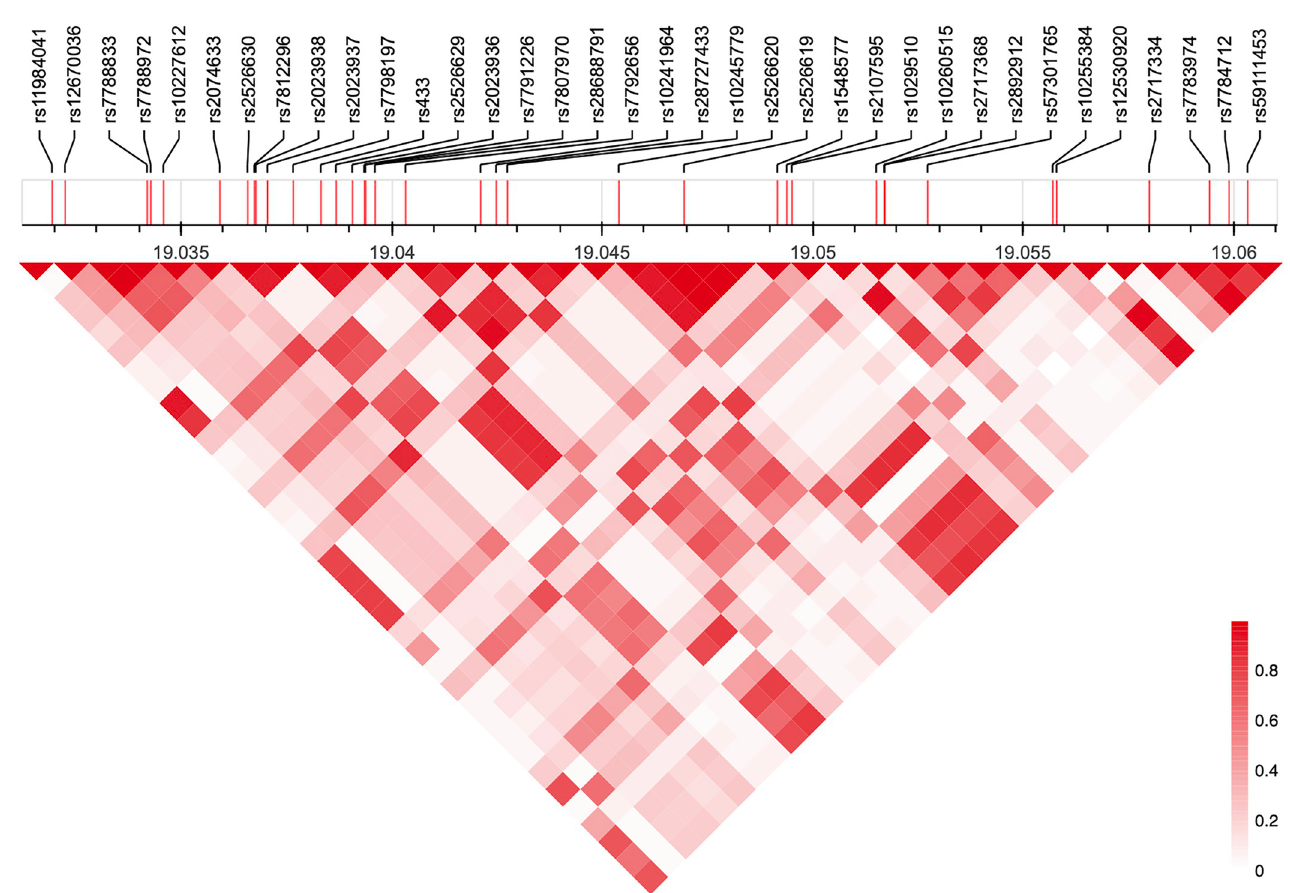
Fig 2. LD relationships among GWAS SNPs in the HDAC9 -associated CAD risk locus. Shown here is the full LD heatmap for GWAS SNPs in the HDAC9 - associated CAD risk locus.